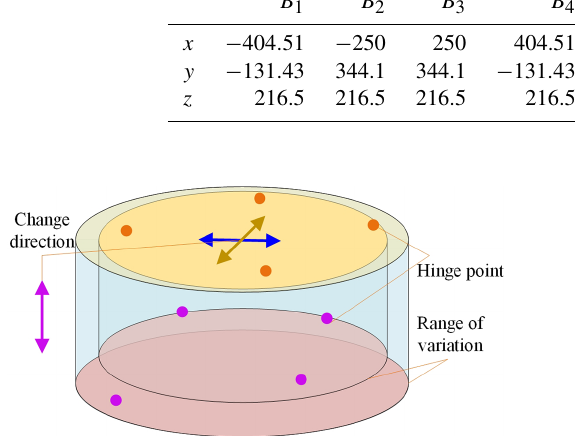
Figure 2. Initial shape of end actuator.